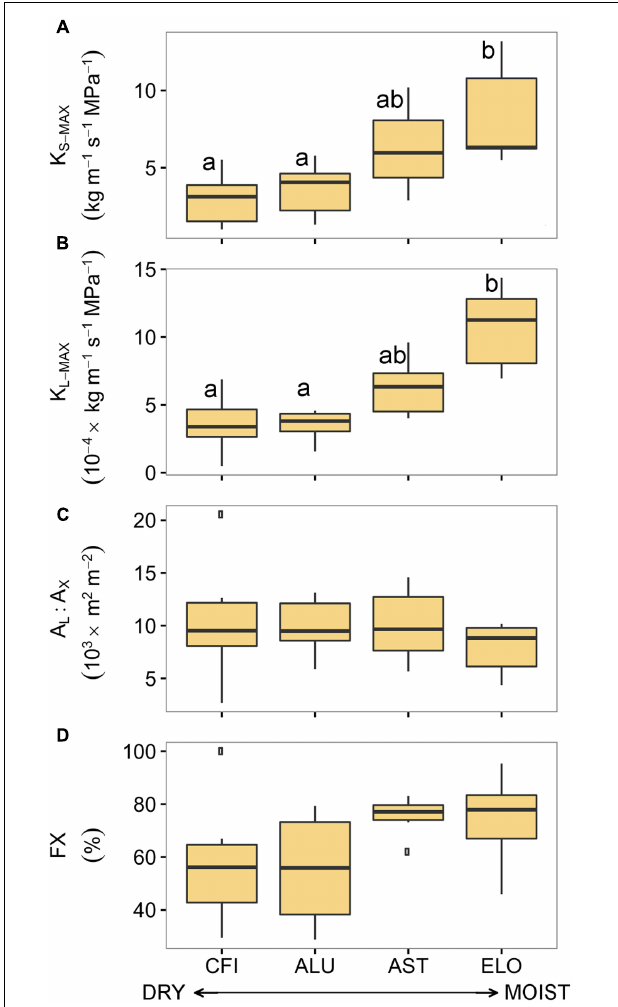
FIGURE 4 | Hydraulic traits of four sessile oak populations sampled across an aridity gradient: (A) xylem-specific maximum hydraulic conductivity, (B) leaf-specific maximum hydraulic conductivity, (C) leaf-to-xylem area ratio, and (D) functional xylem fraction. Sites are ordered respect to P/PET annual (see Table 1 ). Boxes represent 50% of the data (between the first and third quartiles). Median is shown as horizontal line. Bars extend from the box to the highest/lowest value within 1.5 ∗ inter-quartile range (IQR). Points (outliers) are values > 1.5 ∗ IQR. Letters denote significant differences between sites ( p < 0.05) (see Supplementary Table S4). K S - MAX , xylem-specific maximum hydraulic conductivity; K L - MAX , leaf-specific maximum hydraulic conductivity; A L : A X , leaf-to-xylem area ratio; FX, functional xylem